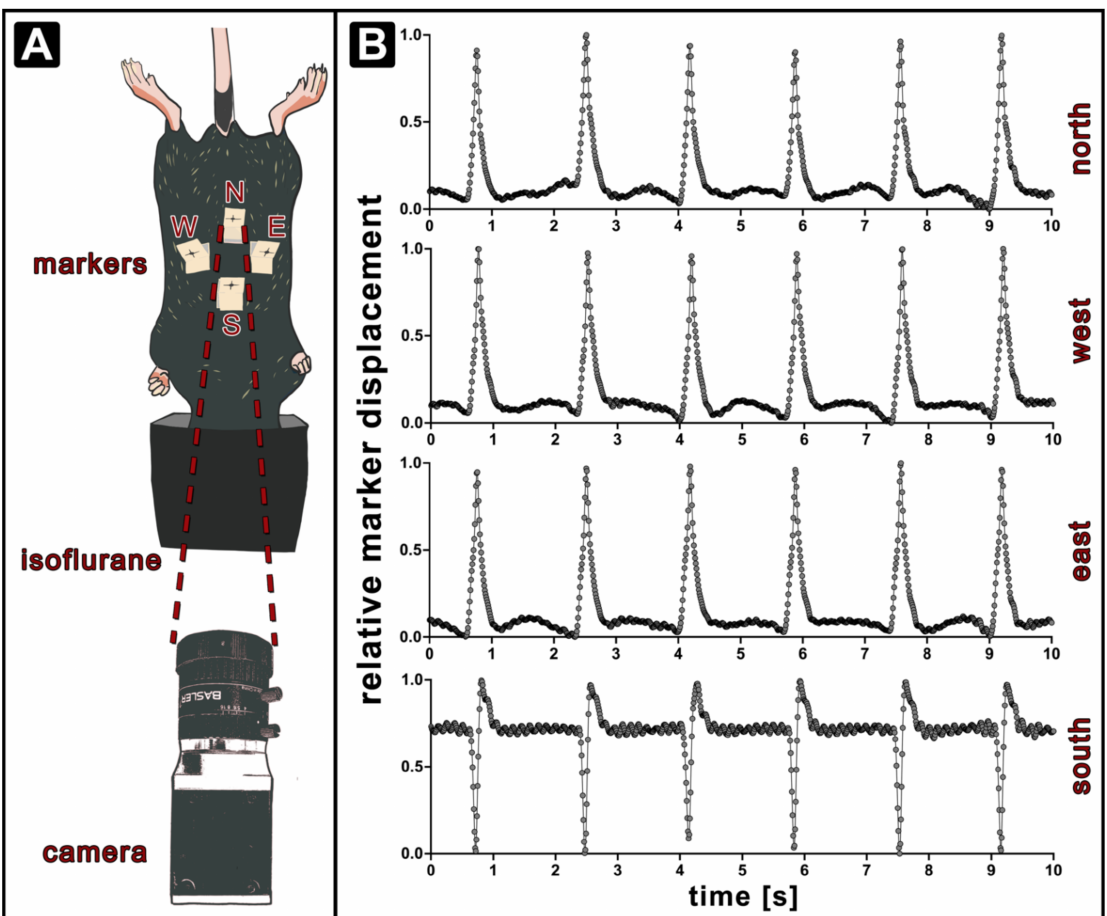
Figure 1. Setup for optical respiratory dynamics tracking (ORDT). The mouse is placed on a plastic rail with the chest and abdomen facing upwards and the nose exposed to isoflurane gas through a face mask. Four markers are positioned on the fur of the mouse and their movement is recorded by a camera positioned 25 cm away at an angle of 40 ◦ . The paper markers are placed on skin/fur at different sites. South marker (S) is trapped on the skin above the sternum. East (E) and west markers (W) are both placed at the location of the 12th rib and north marker (N) is positioned on the area of the abdomen ( A ). Exemplary marker traces of a wt mouse at 38 days from birth after the pre-processing procedure show that the modulations in N, E and W markers are following the same shape, while the S marker traces a different motion ( B